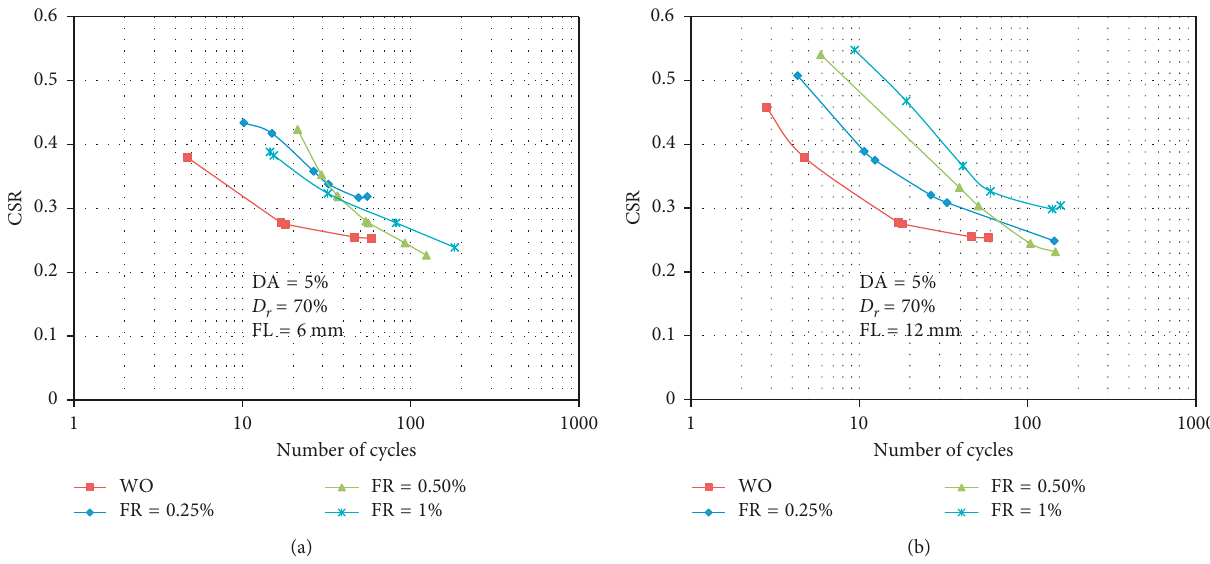
Figure 6: Variation of CSR with the number of cycles considering the effect of fiber length (a) FL fibers, FR: fiber ratio, D r